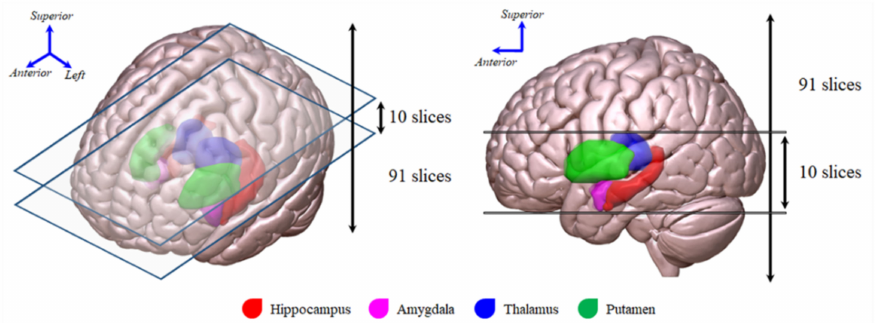
Figure 3. Slices of interest, including the hippocampus, amygdala, thalamus, and putamen, that were used for the 18 F-FDG PET image